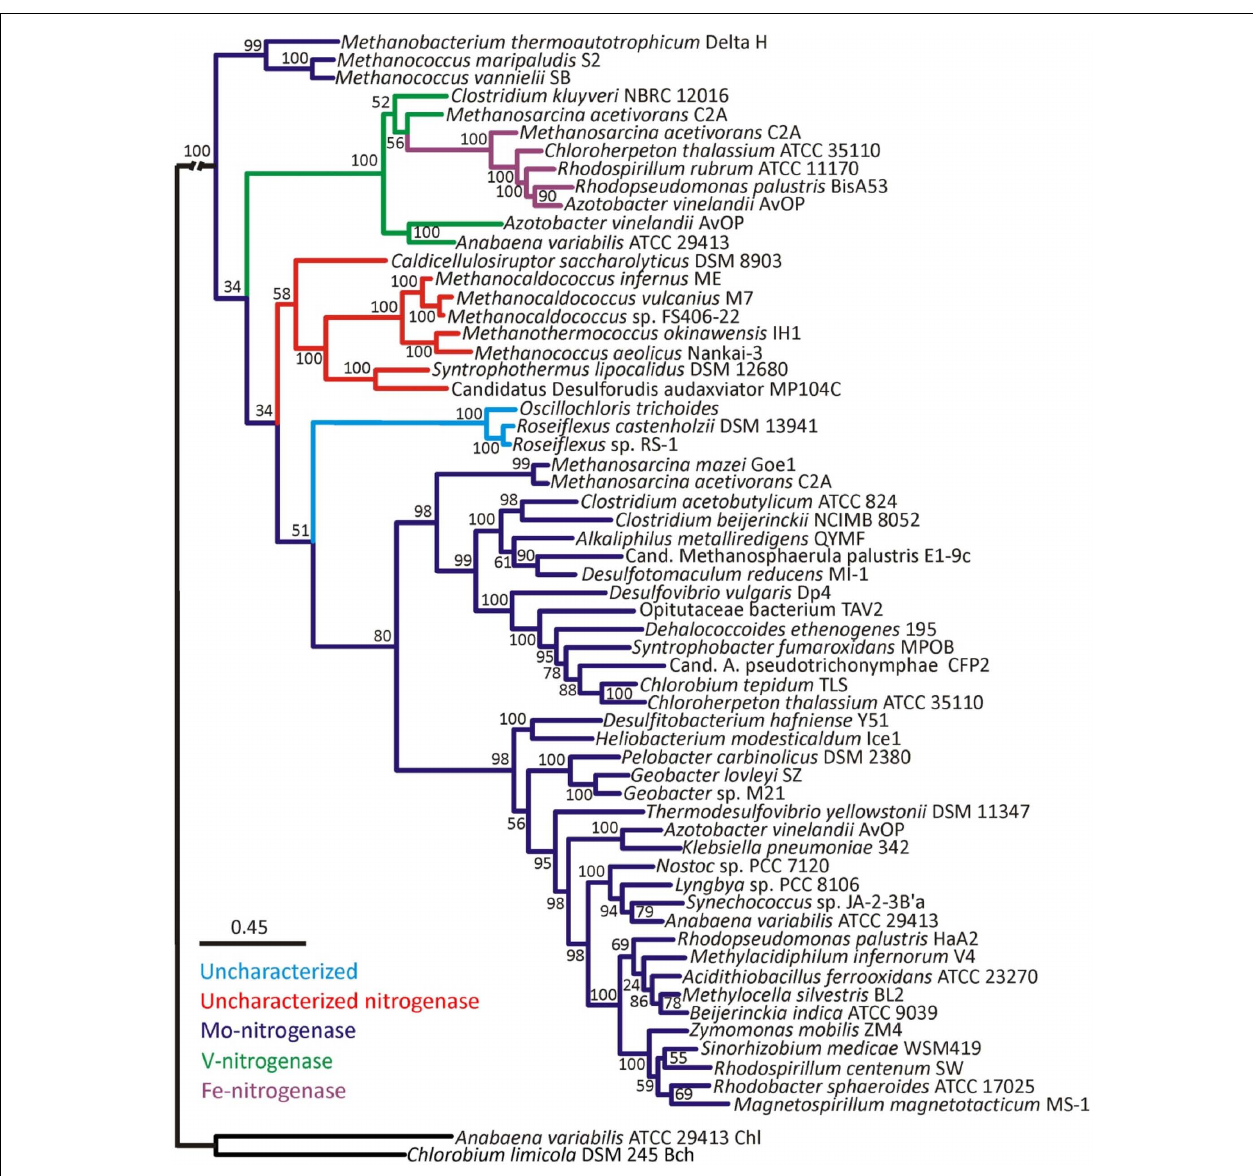
green (V-nitrogenase,Vnf), purple (Fe-nitrogenase, Anf), red (uncharacterized nitrogenase), and light blue (uncharacterized homolog).The hash at the root was introduced to conserve